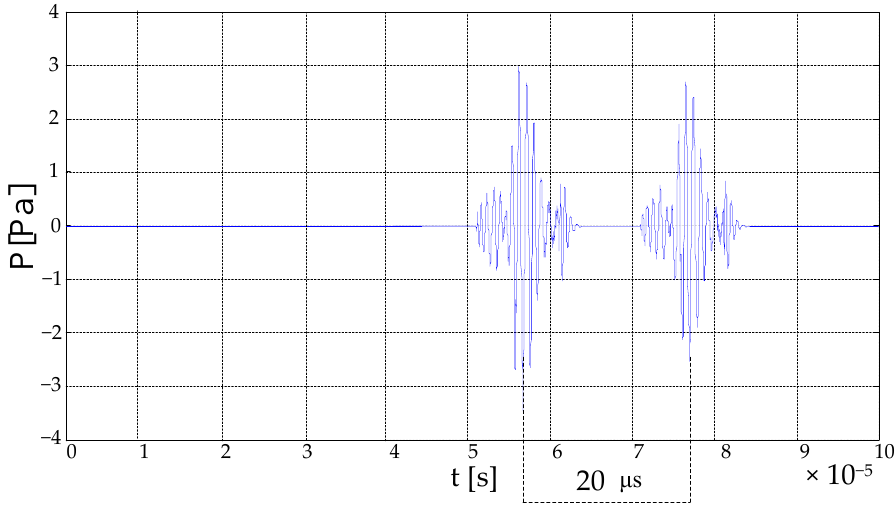
Figure 11. The magneto-acoustic signal waveform of the ring. As shown in Figure 11, the ring is excited to produce two sound waves. The time interval between two sound waves is, The time interval corresponds to the time of the propagation of the ultrasound between the two boundaries of the ring. Therefore, these two sound waves are the sound signals excited by the two boundaries of the